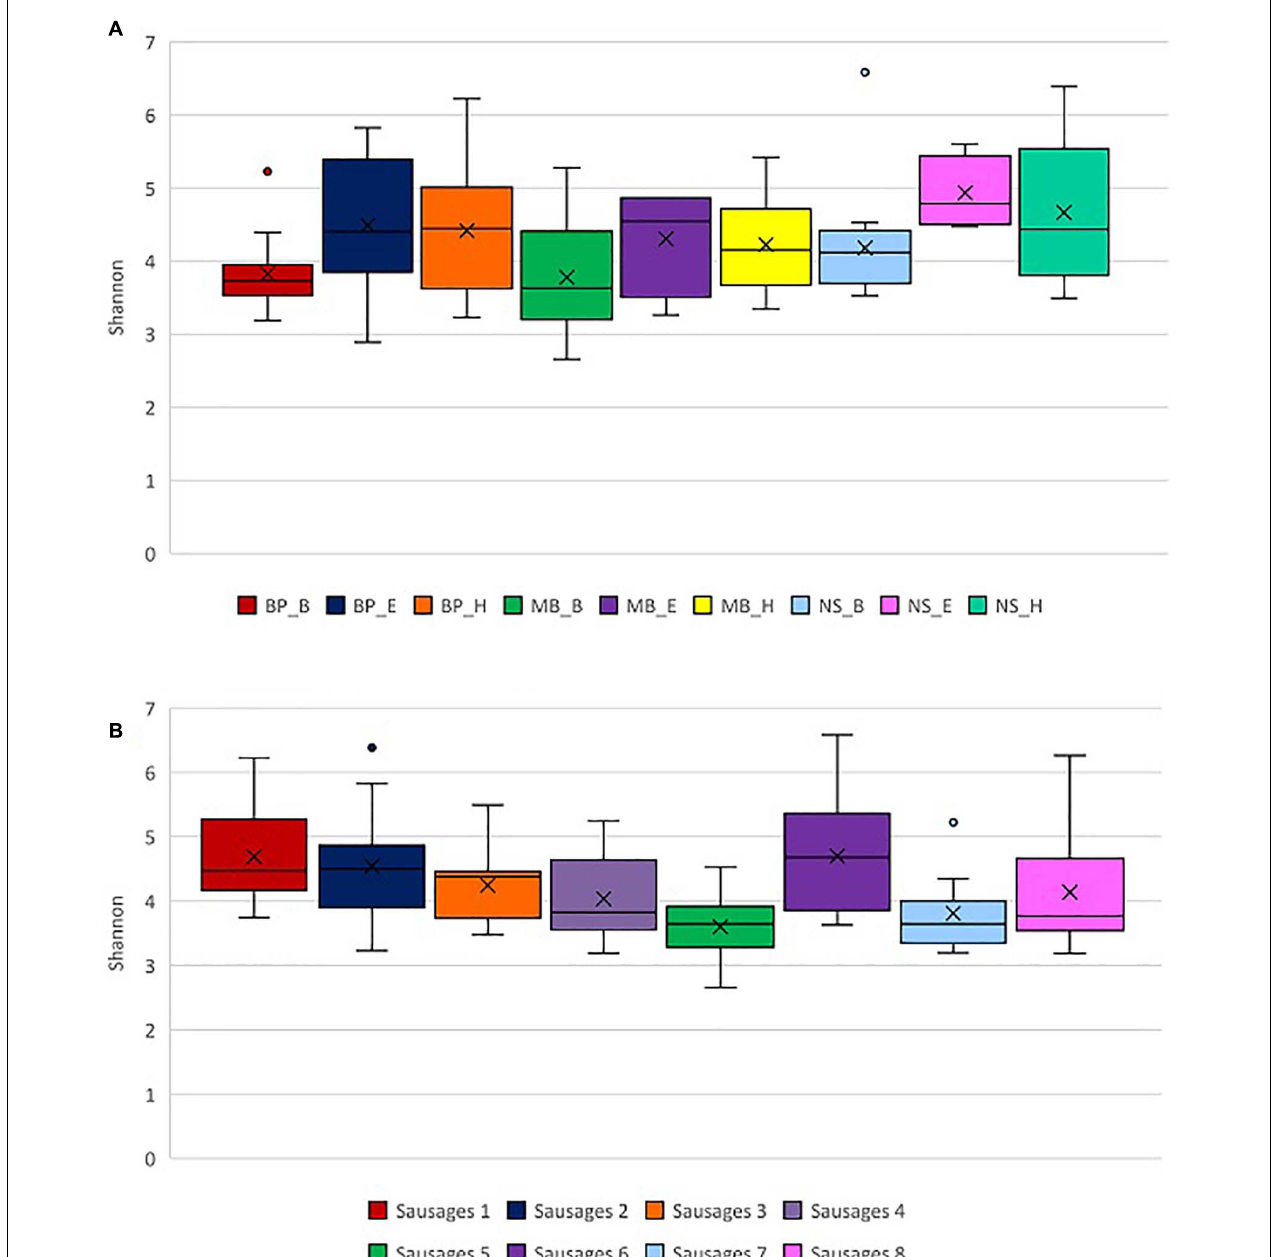
FIGURE 4 | Exploration of alpha diversity based on the Shannon index in sausage samples. (A) Comparison of the different sausage samples. (B) Comparison of the different protocols of DNA extraction. Statistical analysis was performed using the Kruskal–Wallis test. Each of the eight sausages and of the nine DNA extraction protocols is indicated by a unique color; abbreviations for the samples and the protocols are given in Tables 1 , 2 ,